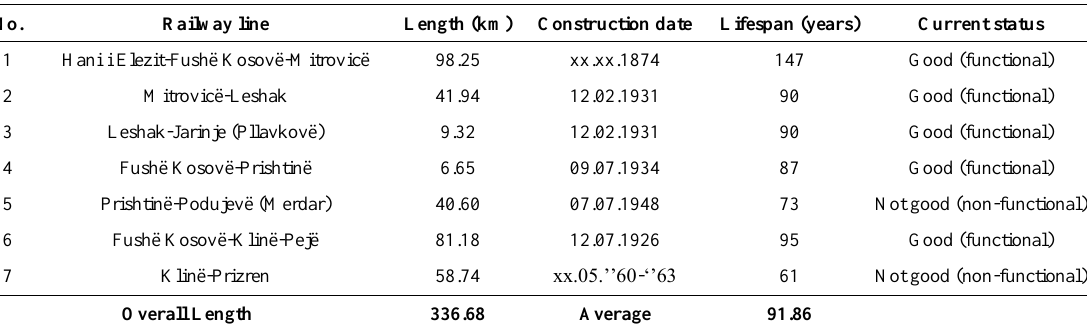
Table 1. Railway lines for general transport